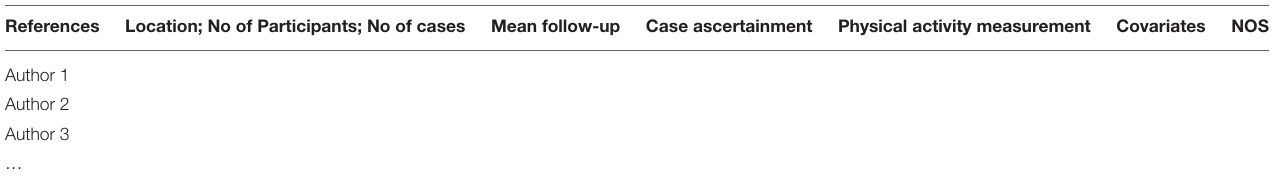
TABLE 1 | The characteristic of included